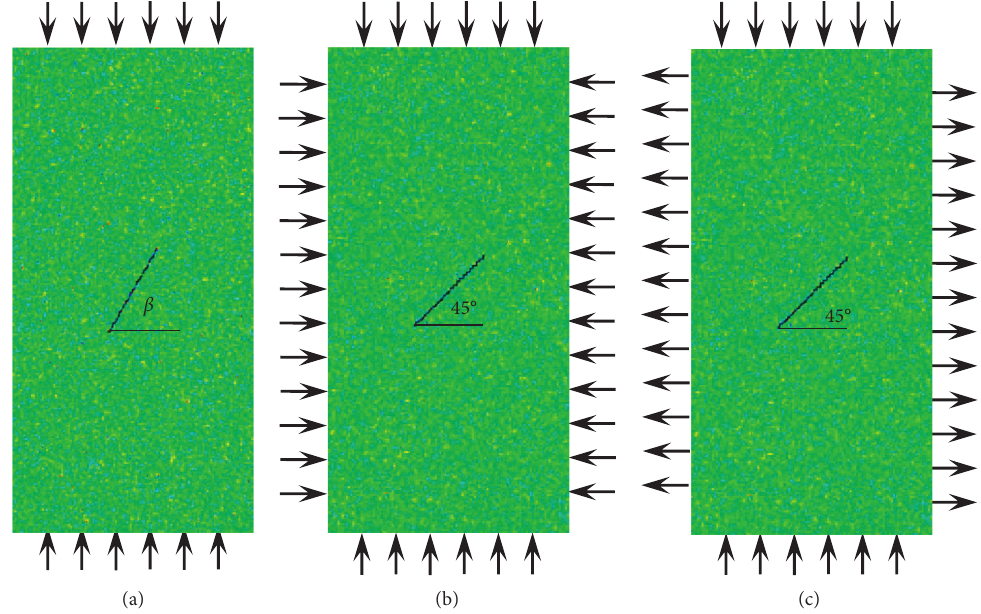
Figure 2: Loading conditions of numerical models based on the RPFA-Flow software: (a) uniaxial compression; (b) confining compression; (c) confining